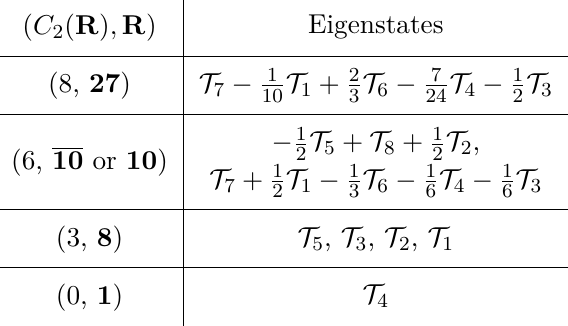
Table 7 . Representations of SU(3) gluons { 8 , 8 , 8 , 8 } at channel { 12 } .